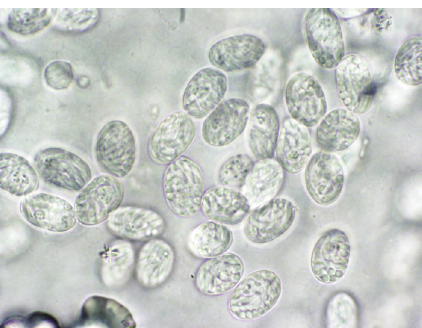
Figure 1: Sporocysts of Klossiella equi found on centrifugal flotation of urine with Sheather’s sugar solution (1.27 sp.